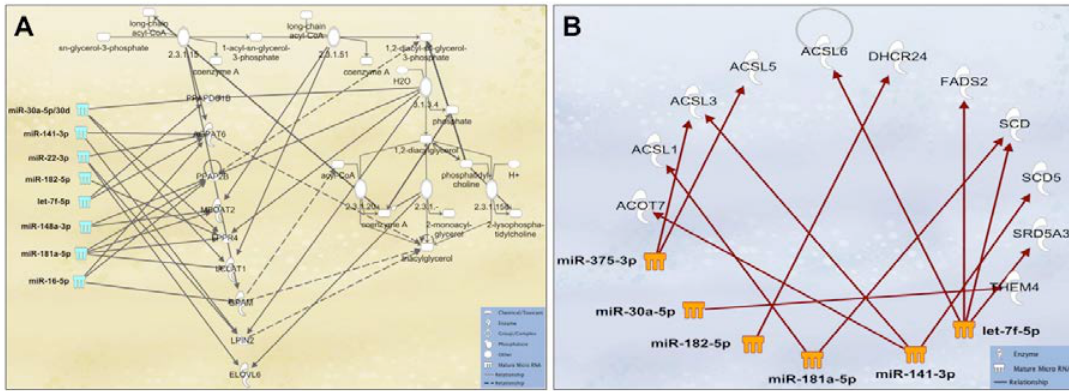
Figure 5. Some of the most highly expressed miRNAs in HM cells are involved in milk synthesis, regulating various pathways within complex molecular networks. ( A ) 8 highly expressed miRNAs (shown in light blue color) were identified to control the production and maintain the level of triacylglycerol in milk fat; ( B ) 6 highly expressed HM cell miRNAs (shown in orange color) that regulated different genes associated with fatty acid biosynthesis, including oleic acid, stearic acid, and palmitic acid.